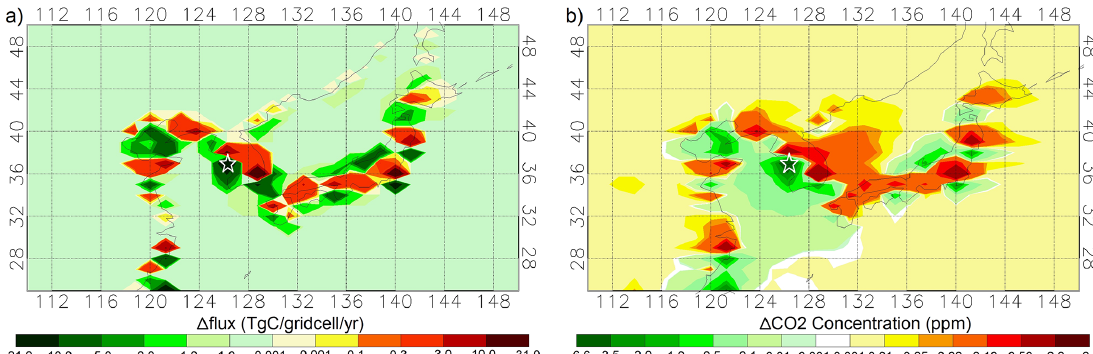
Figure 6. Regional fluxes difference and simulated surface CO 2 concentration differences (experiment minus control) and the location of GLOBALVIEW monitoring site TAP. (a) Flux difference; (b) concentration difference. Stars mark the location of the TAP